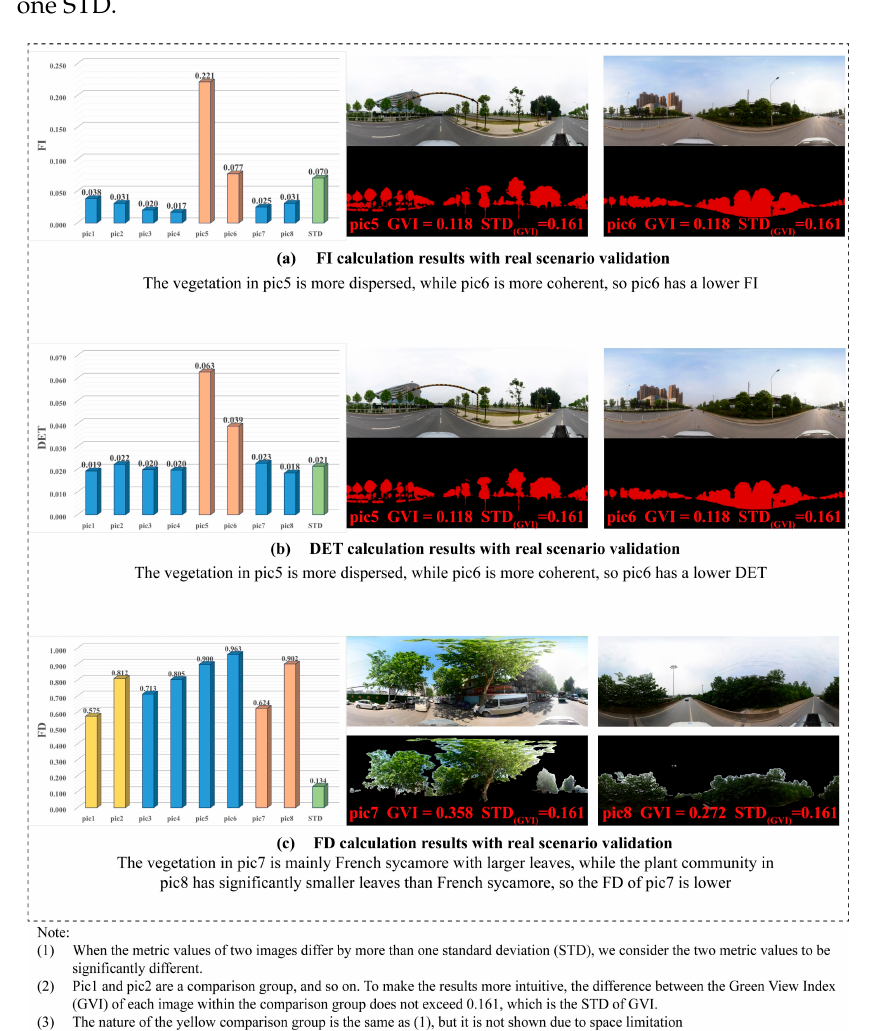
Figure A1. Numerical comparison of FI, DET, FD, and actual scene verification.